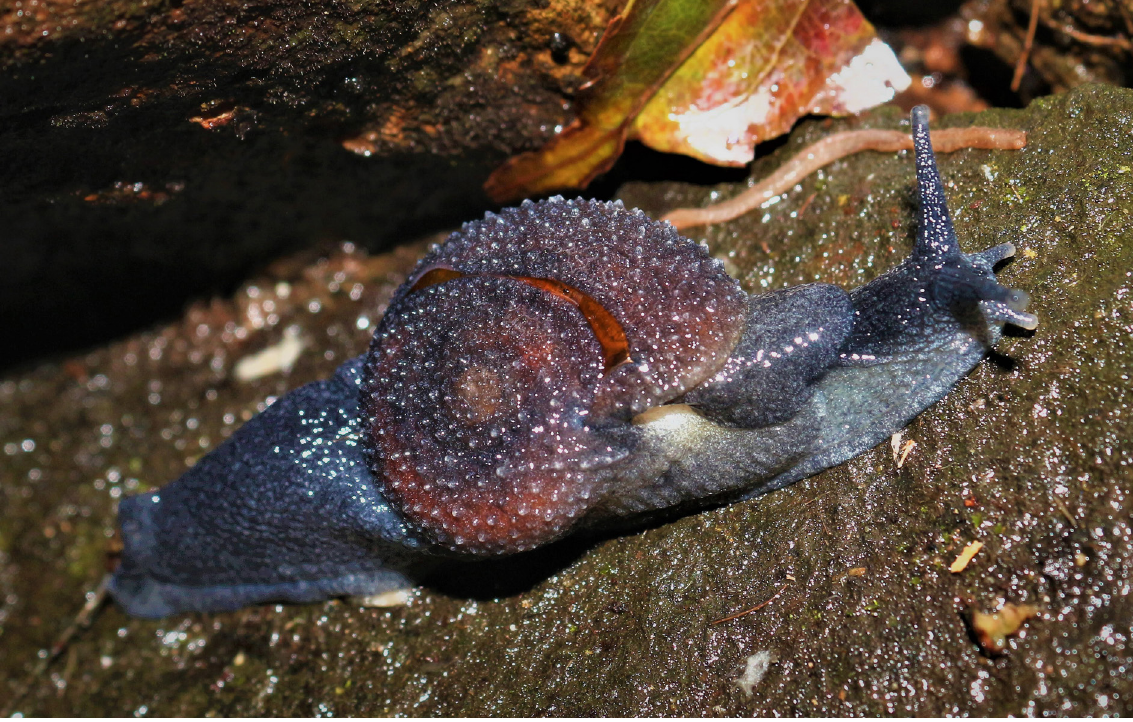
Fig. 5. Live individual of Varadia amboliensis Bhosale, Thackeray, Muley & Raheem gen. et sp. nov. from the site near Amboli waterfall. Image: O.